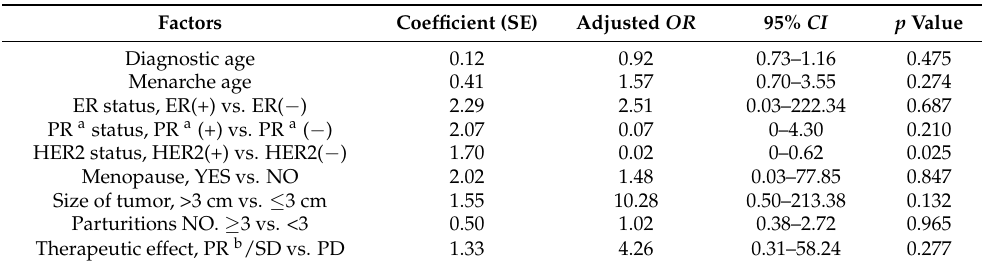
Table 2. Multivariate regression analysis of relationship between ctDNA mutations and clinical